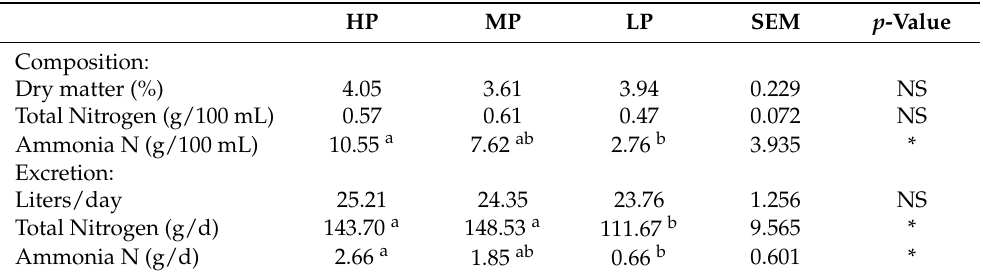
Table 5. Composition of urine and urine excretion by dairy cows on feeding diets with high protein (HP), medium protein (MP), and low protein (LP) levels. HP MP SEM